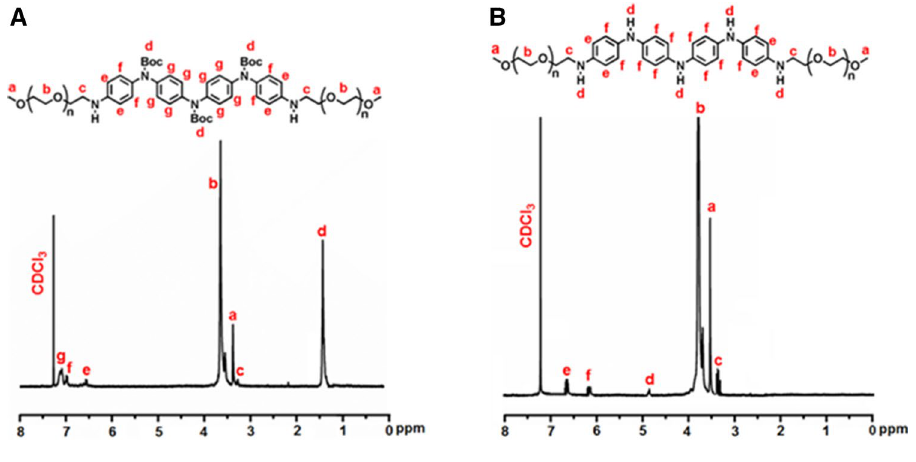
Figure 3. 1 H NMR spectra ( A ) P2, and ( B )